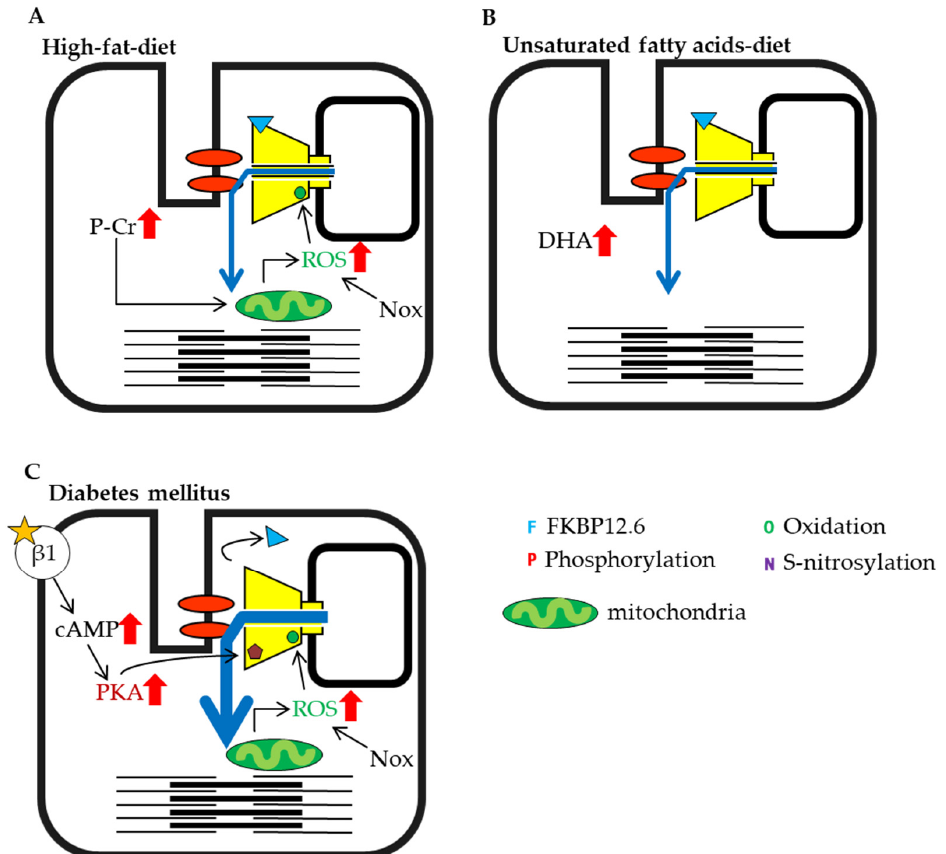
Figure 4. Schematic representation of cardiac ryanodine receptor (RyR2) modulation by intracel- lular factors under different conditions (part 2). ( A ) High-fat diet. ( B ) Unsaturated fatty acid diet. ( C ) Diabetes mellitus.